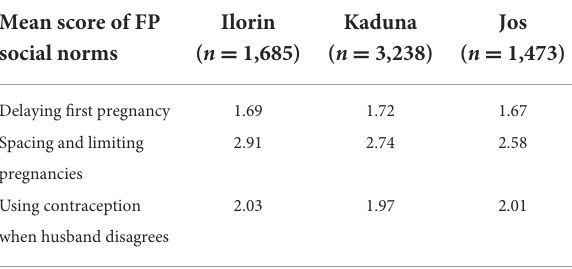
TABLE 4 Mean score of FP social norm factors by